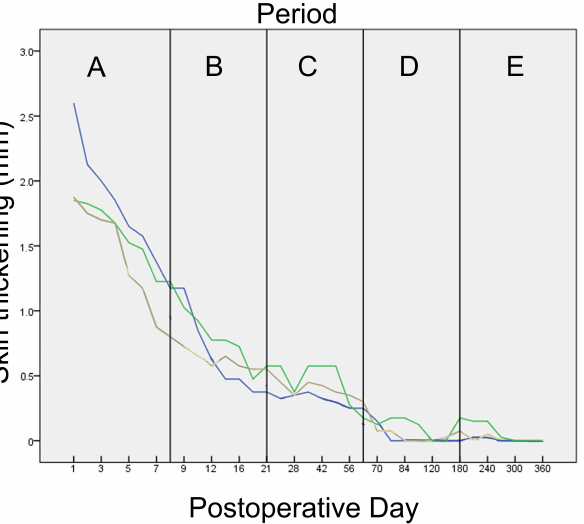
Figure 2. Median skin thickening (in mm) with each technique (blue: staples, green: glue, gray: intradermal) at each time point.